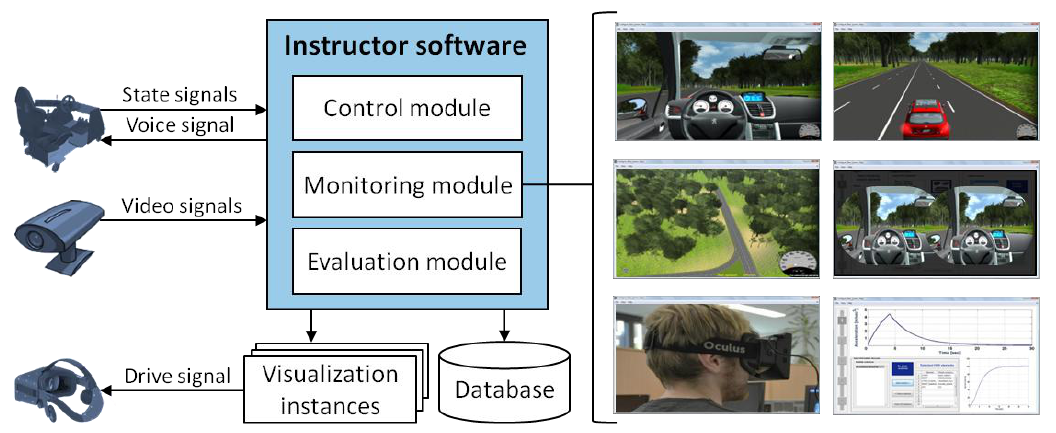
Figure 9. Structure and main input/output signals of the instructor software tool.